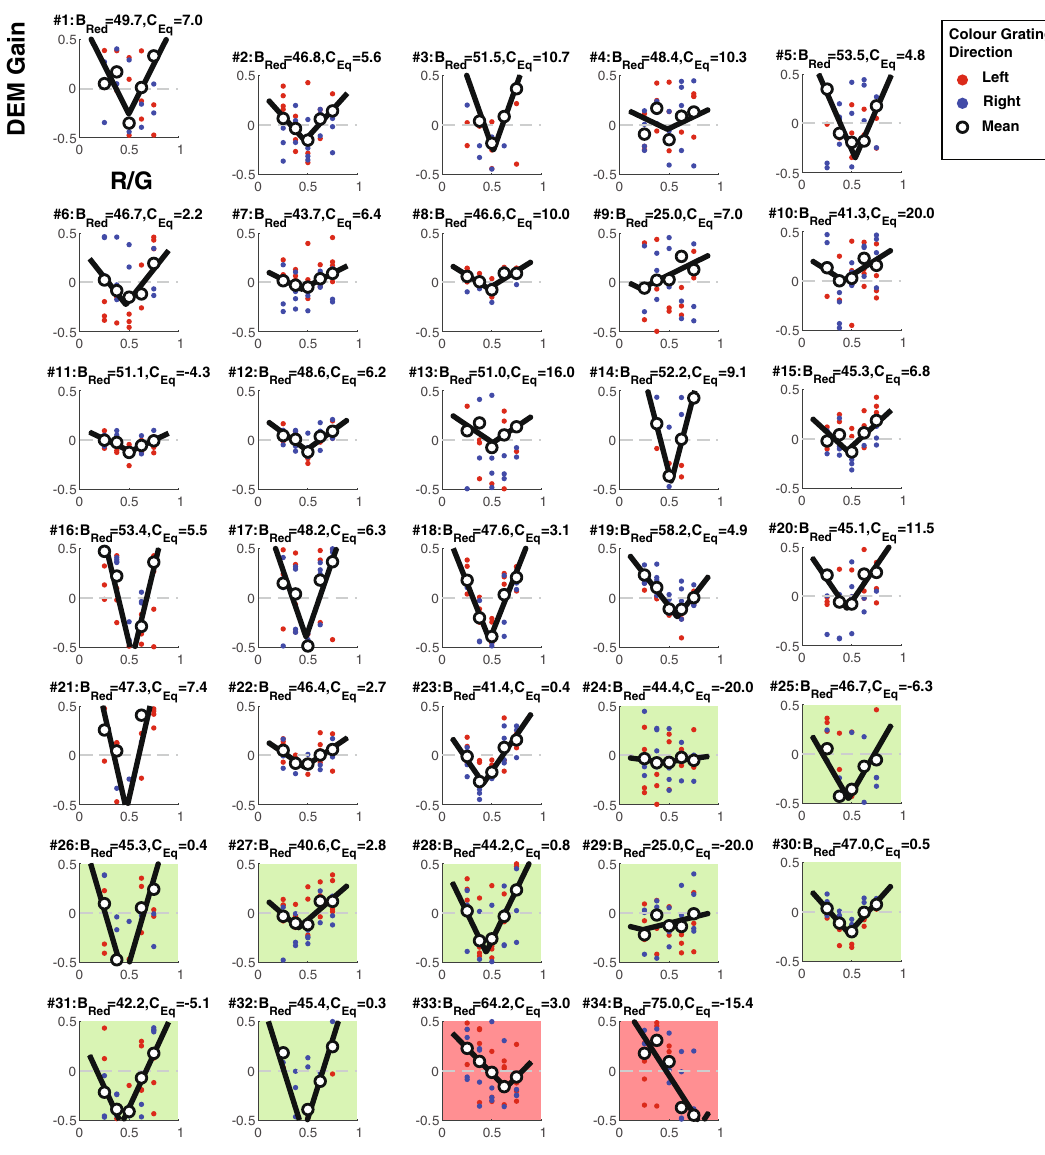
Figure 6. DEM gain (signed for direction of colour component as Fig. 5) measured with a 20% fixed luminance-contrast component drifting at 16 deg/s. Data have been plot on common axes to allow visual comparison of the ‘V’ fits; some data lies outside the axis range. Plots in green, red and white panels show data from deuteranopes, protanopes, and CVn observers respectively. Red and blue symbols show gain-estimates from trials when the coloured grating moved left or right respectively, with the mean-gain across trials indicated by open